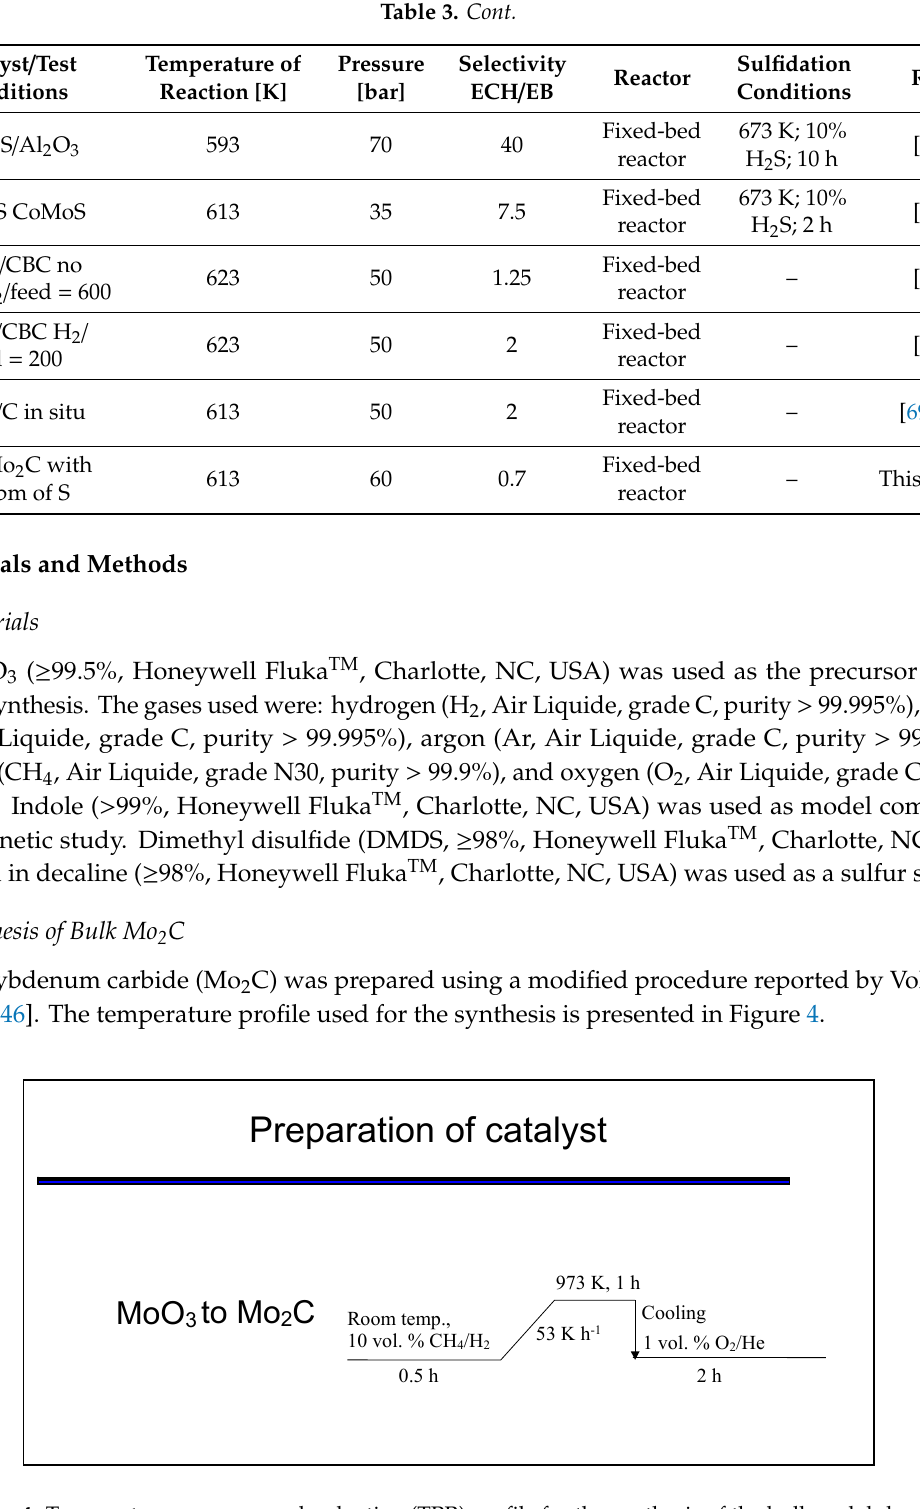
Figure 4. Temperature-programmed reduction (TPR) profile for the synthesis of the bulk molybdenum carbide catalyst.